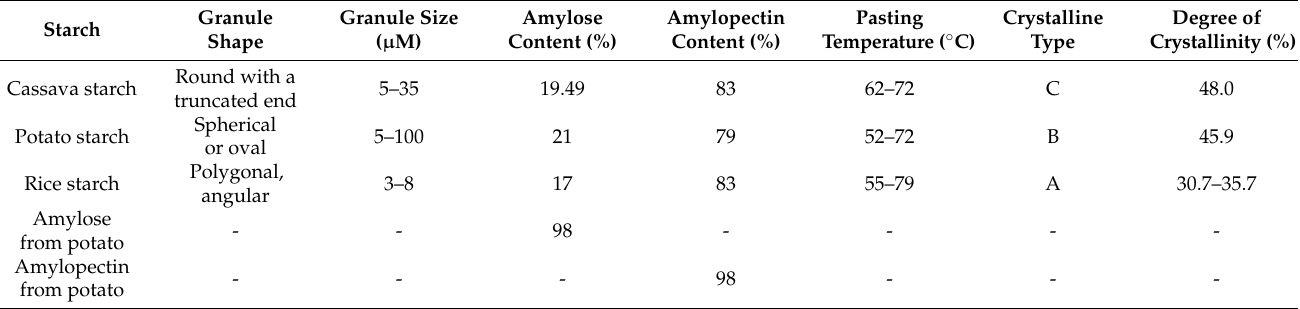
Table 3. Physical properties of starch from different botanical sources